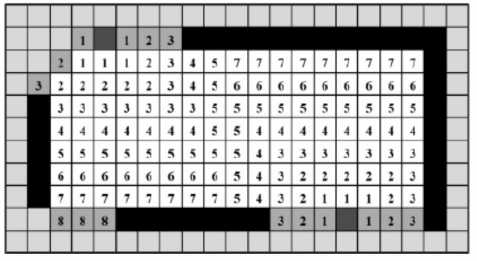
Figure 2. Extracted boundaries the distance